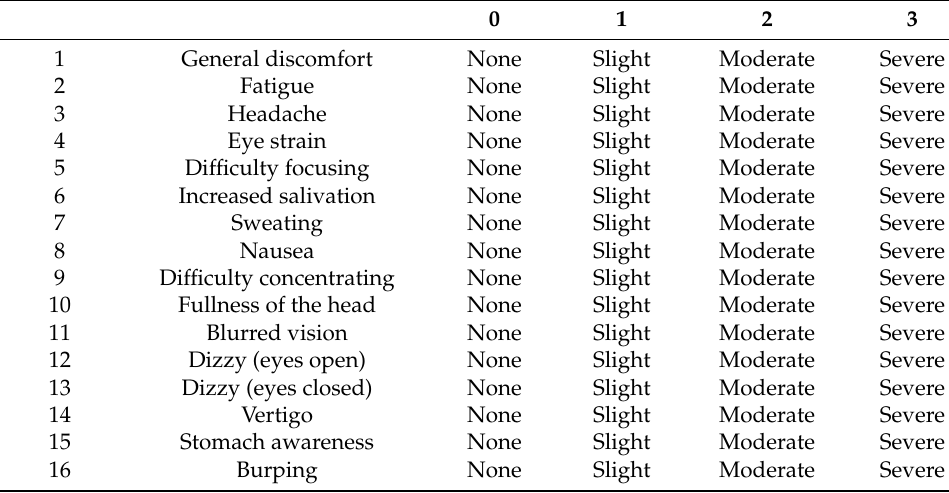
Table 2. Simulator Sickness